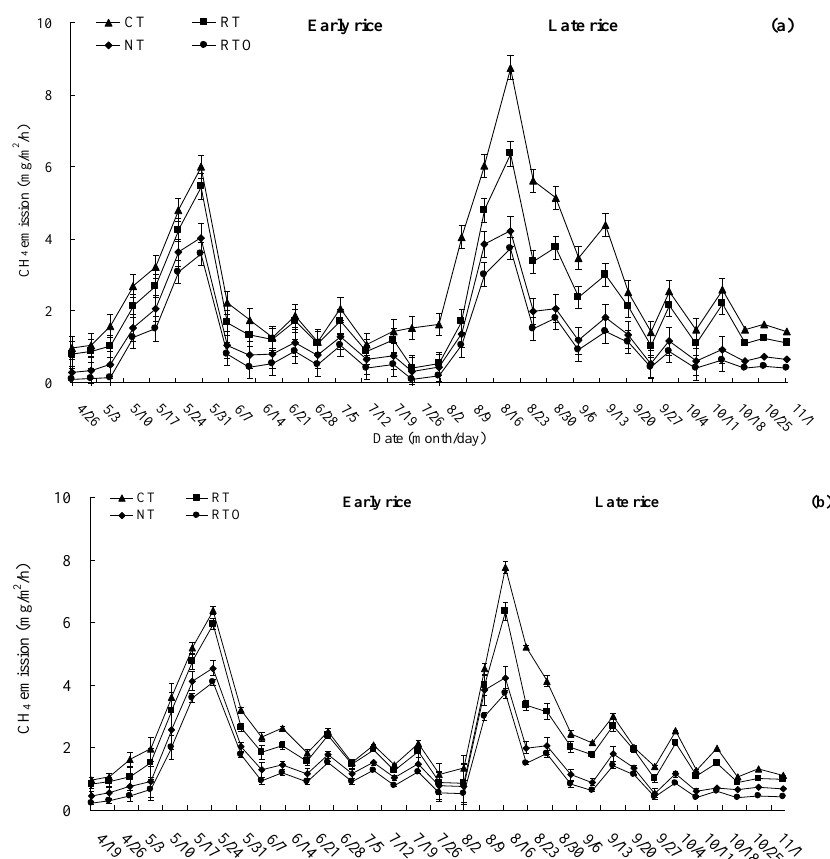
Figure 3. Impacts of different short-term tillage managements on CH 4 emission flux from double-cropping rice field in 2019 ( a ) and 2020 ( b ).